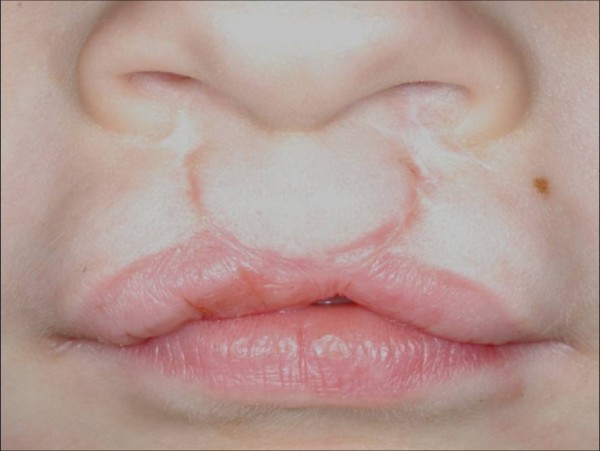
Detail of the upper lip of the patient in Figure 1showing a whistling defect.